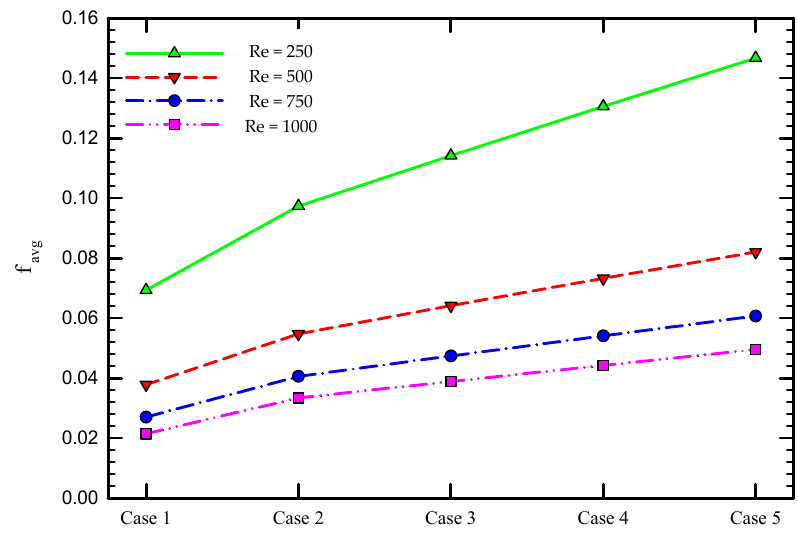
Figure 11. Friction coefficient for the captured cases at different Re numbers for ϕ = 0%.